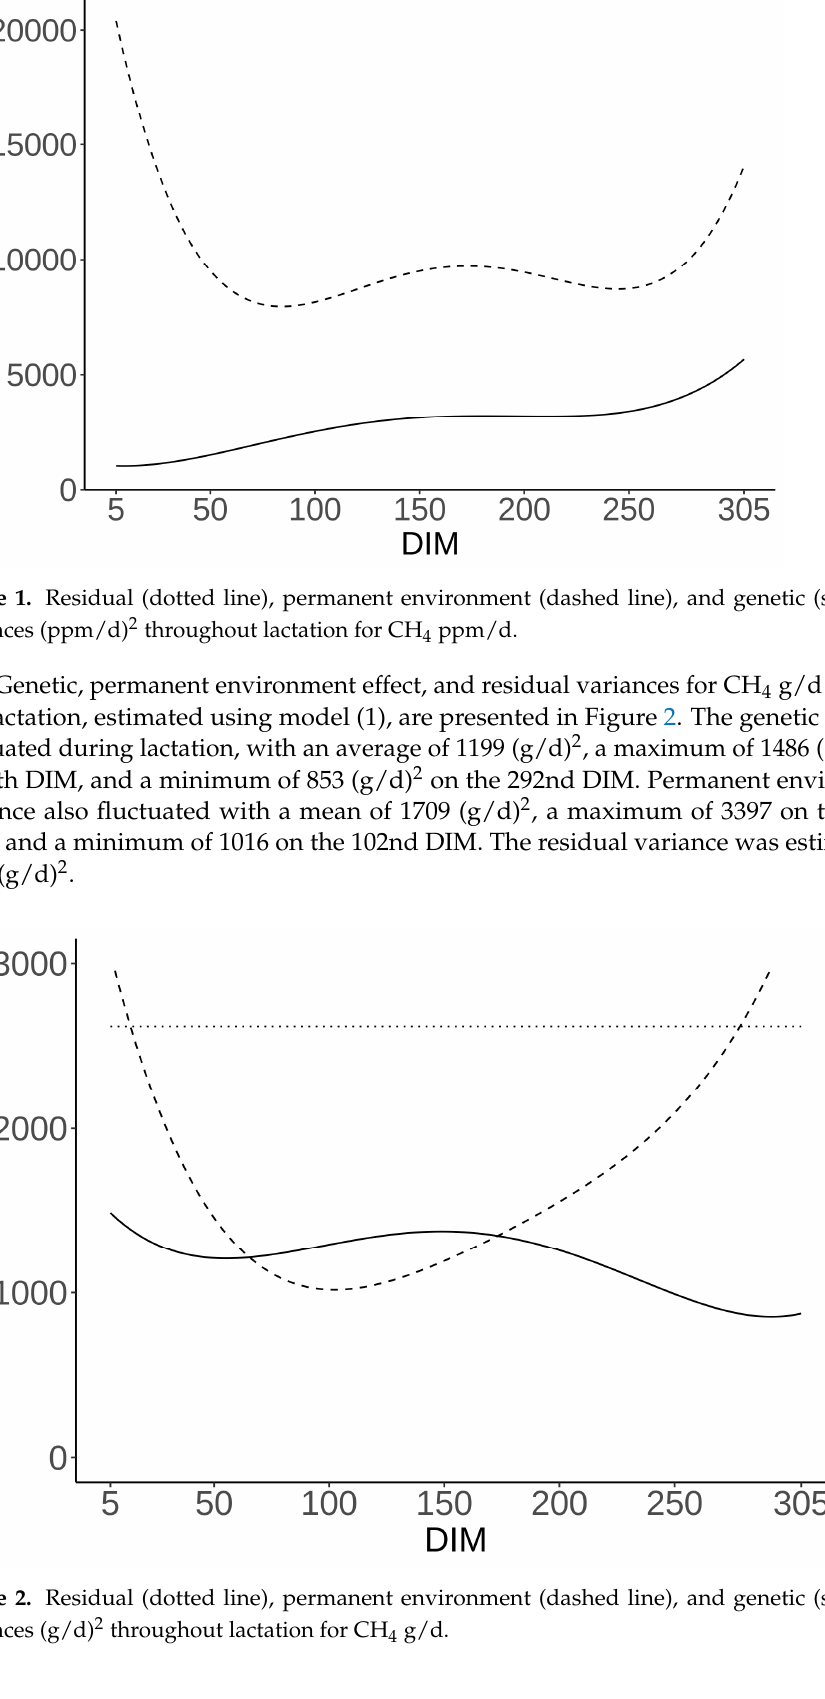
Figure 2. Residual (dotted line), permanent environment (dashed line), and genetic (solid line) variances (g/d) 2 throughout lactation for CH 4 g/d.